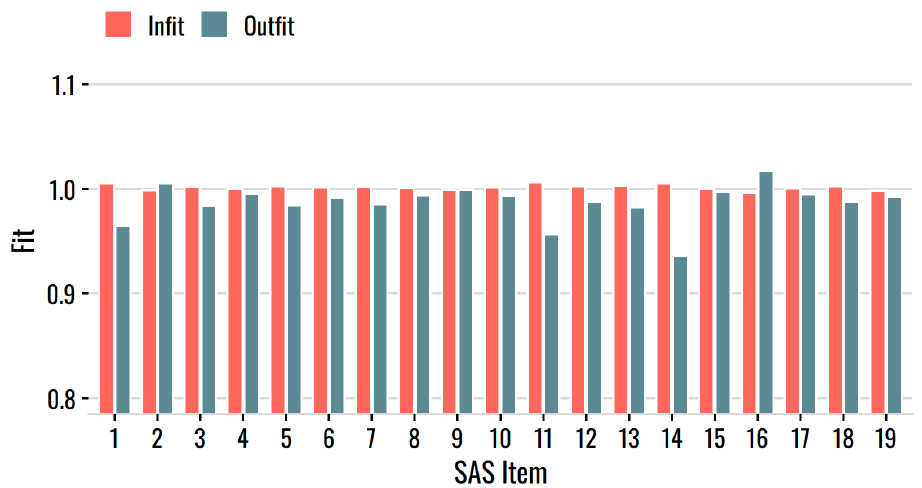
Figure 4. Infit and Outfit statistics for the SAS items.